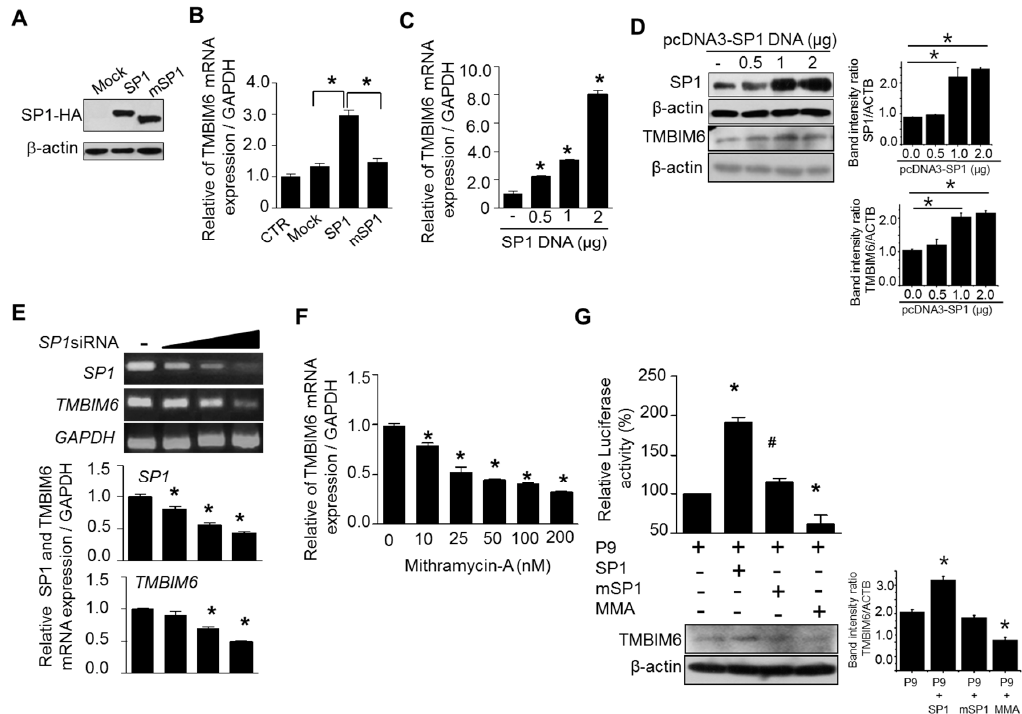
Figure 5. Sp1 activity and expression level are associated with human TMBIM6 expression pattern. ( A ) Western blot showing the overexpression of HA tagged Sp1 and deletion mutant of Sp1. ( B ) The effect of wild type and mutant Sp1 overexpression on TMBIM6 mRNA expression in HT1080 cells, measured by qRT-PCR. The empty vector pCMV-3T3A was used as the vector control (V-CTR); CTR, control non-transfected cells. ( C ) qRT-PCR analysis of TMBIM6 mRNA levels in HT1080 cells transfected with different concentration of wild type Sp1 construct for 24 h. ( D ) Western blot showing the Sp1 and TMBIM6 expression levels after transfecting wild type Sp1 in HT1080 cells for 24 h, respective band intensity ratio with β -actin. ( E ) (upper panel) RT-PCR data showing the Sp1 and TMBIM6 mRNA level after transfection of different concentrations of Sp1-siRNA for 24 h; (lower panel) the respective data of qRT-PCR analysis of Sp1 and TMBIM6 mRNA levels in HT1080 cells. ( F ) qRT-PCR analysis of TMBIM6 mRNA levels in HT1080 cells after treatment with different concentrations of the Sp1 transcriptional activity inhibitor mithramycin-A for 24 h. ( G ) The pGL3-P9 construct of TMBIM6 was transiently transfected into HT1080 cells with either wildtype or mutant Sp1 at the ratio of 2:1 for 24 h, and then the cells were lysed and the luciferase activity was measured. The mithramycin-A effect on Sp1-induced luciferase activity with Sp1 overexpression was also tested at the concentration of 200 nM. The pGL3-basic vector was used as the control. The upper panel shows the promoter activity, while the lower panel shows the western blot for TMBIM6 expression and respective band intensity ratio with β -actin under same conditions. The results are the mean ± SD from n = 3 independent experiments. ‘*’ indicate signi fi cant differences from the control. ‘#’ indicates the significant difference of P9 activity between Sp1 and mSp1 transfected cells.